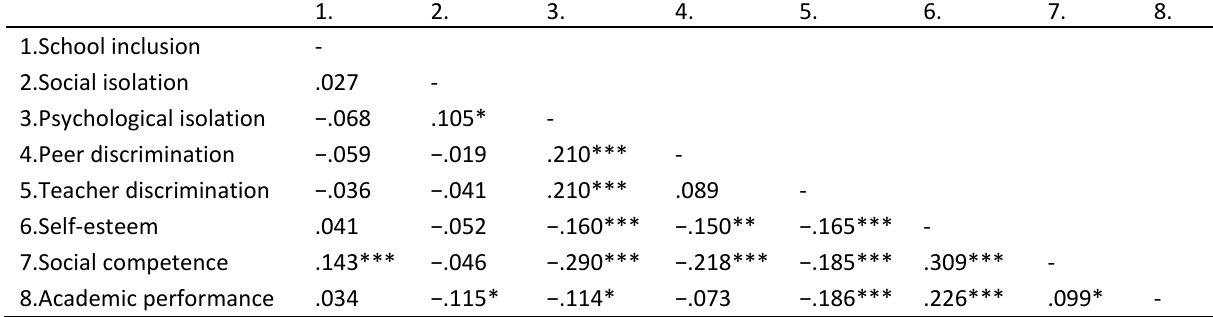
Table 3. Correlations between predictor variables and dependent variables.